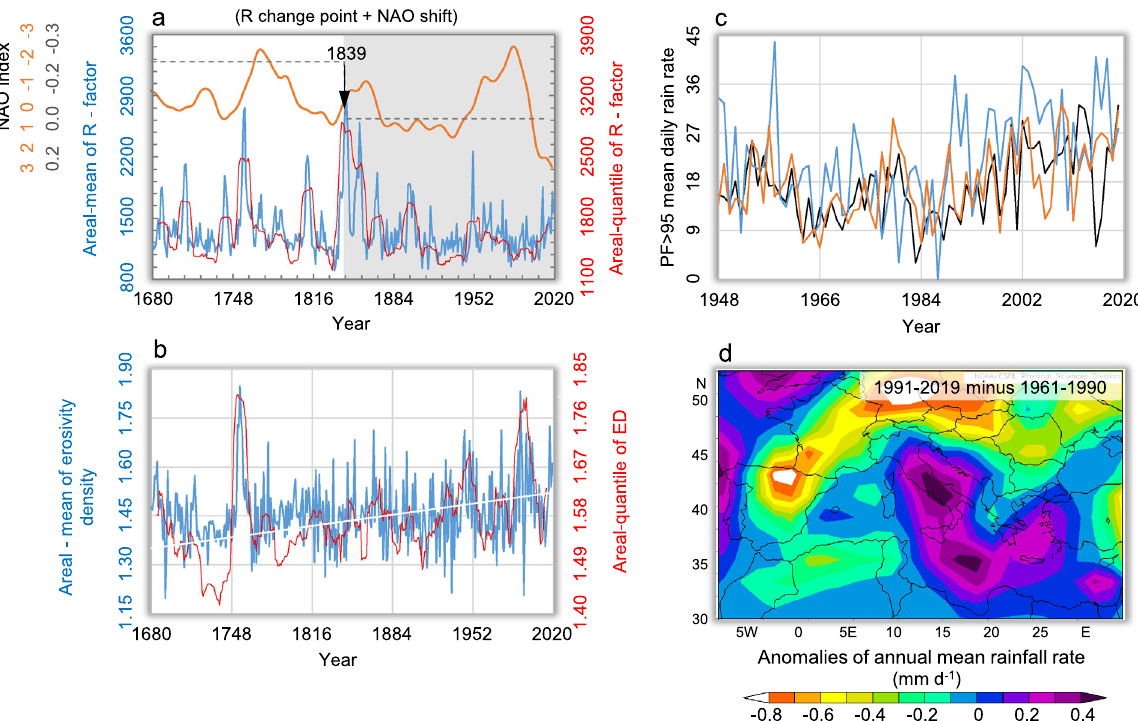
Figure 4. Overview of several precipitation patterns over MedCA. ( a ) Timeline evolution of annual rainfall erosivity reconstructed by Eq. (1) (blue curve) and its quantile with return period (RP) = 30 years (red curve) in a 21-year running window (in MJ mm hm −2 h −1 year −1 ) and with the related plynomial trend (white curve) after the change-point. Horizontal grey dashed lines are mean values of the North Atlantic Oscillation (NAO) for two periods (reversed axis), calculated from the proxy-based multidecadal winter NAO reconstruction of Trouet et al. 100 (orange line). ( b ) Erosivity density timeline (blue curve) with its quantile with RP = 30 years during the period 1680–2019 (in MJ mm hm −2 h −1 year −1 ). ( c ) Precipitation fraction due to very wet days (PF > 95th percentile) for the MedCA (black curve), northern Italy (orange curve) and Sicily (blue curve) over the period 1948–2019 (in mm d −1 ). ( d ) Anomalies in the spatial pattern of annual mean rain rates (1991–2019 minus 1961–1990) over the Mediterranean region (from NCEP/NCAR reanalysis data, https ://psl.noaa.gov/cgi-bin/ data/getpa